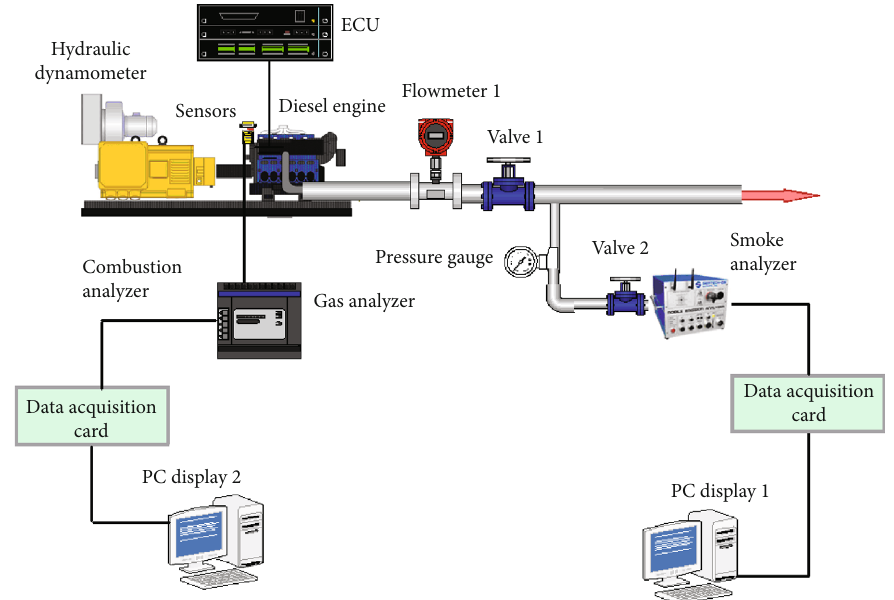
Figure 2: Schematics of experimental device.